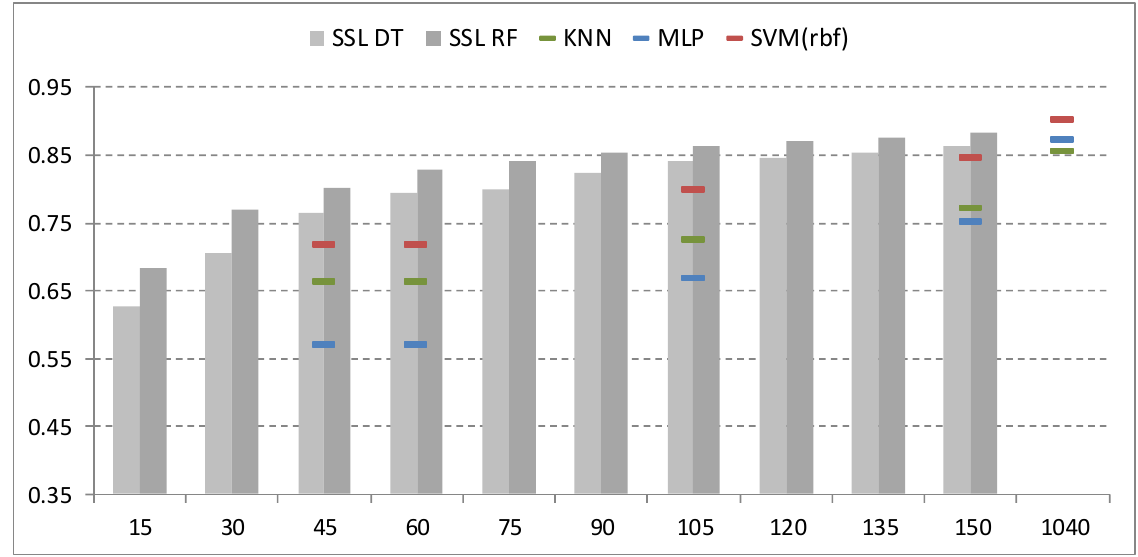
Figure 18. Classification accuracy plots for comparison of SL versus the proposed SSL self-training approach using typical